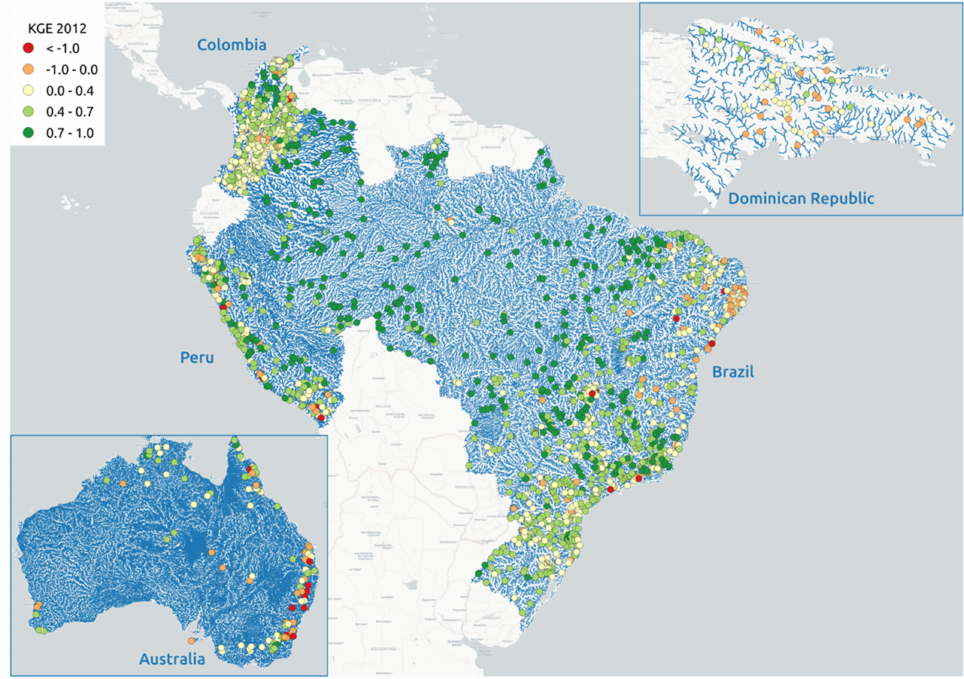
Figure 11. KGE-2012 error metric between the bias-corrected historical simulation and the observed data for Australia, Brazil, Colombia, the Dominican Republic, and